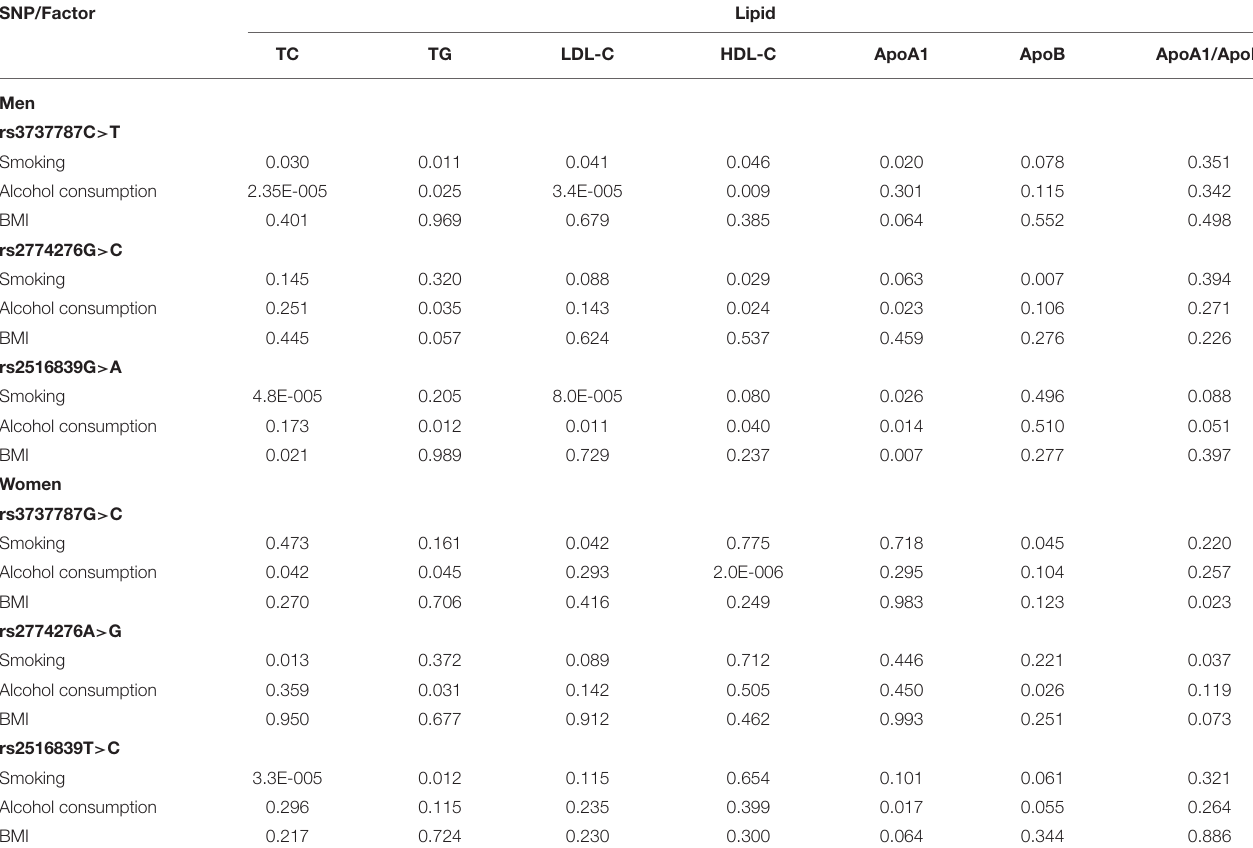
TABLE 7 | The p I values for the interactions of genotypes and alcohol consumption, smoking, and BMI on serum lipid levels. SNP/Factor